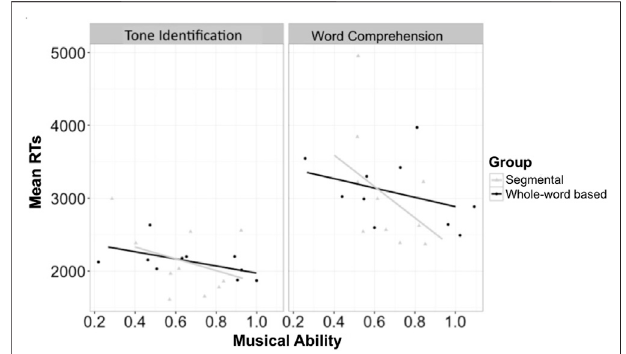
FIGURE 1 | The error rates of tone identi fi cation and word comprehension tasks. FIGURE 2 | The reaction times of tone identi fi cation and word